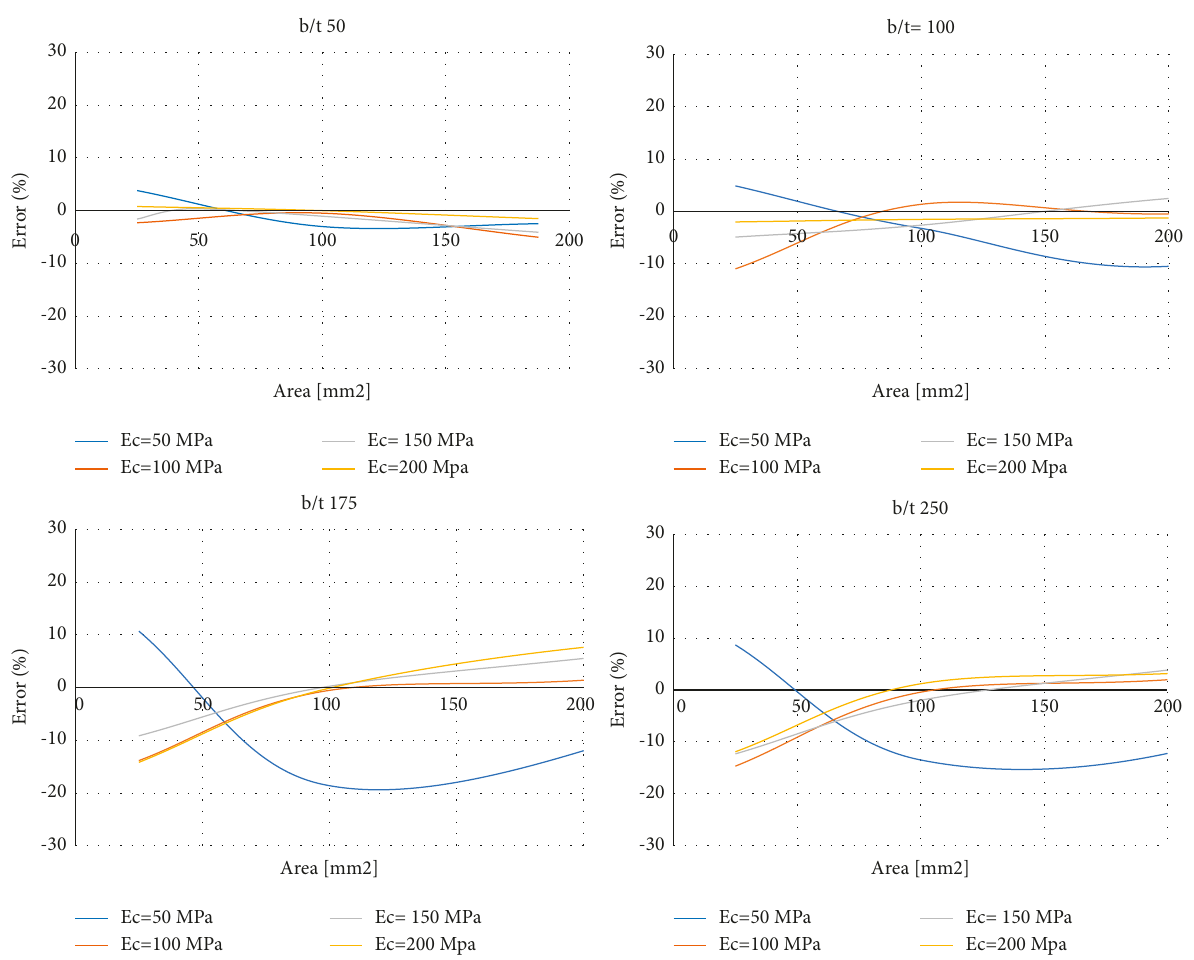
Figure 16: The error of the simplified formula in the case of the internal